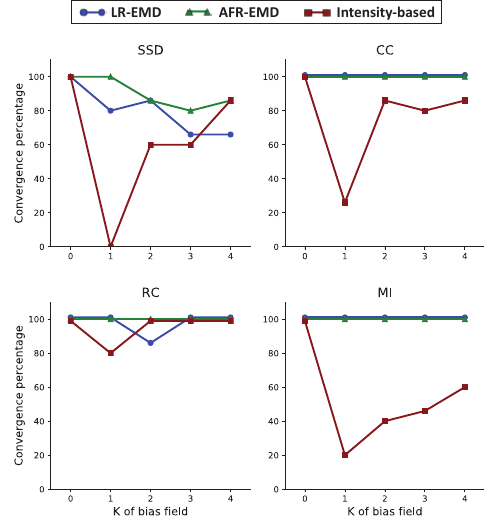
Figure 4. The convergence rate for baseline hierarchical registration with downsampling and our proposed algorithms based on EMD. Each panel corresponds to one similarity measure (SSD, CC, RC and MI). Here, the convergence is defined as T-RMSE error lower than four